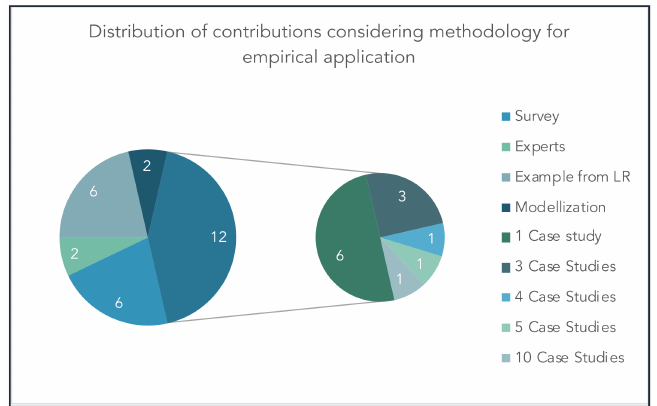
Figure 12. Distribution of the reviewed contributions according to the methodology employed for the empirical